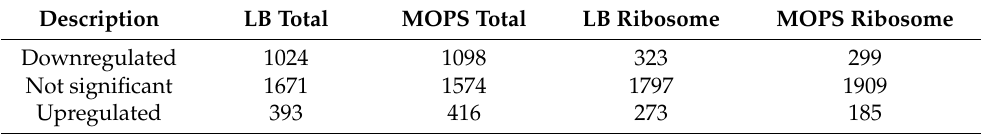
Figure 2. STARPA revealed over 12,000 sRNAs. ( a ) Venn diagram showing the number of identified processing products in total and ribosome-associated RNA libraries, with a cutoff threshold of 10 reads per million or higher. ( b ) Pie charts showing the percentage of identified RNAs by biotype for total and ribosome-associated RNA libraries. ( c ) Venn diagram showing the number of upregulated processing products in the stationary phase, in total, and ribosome-associated RNA libraries deriving from cells grown in LB and MOPS. Table 1. Differential expression analysis. Table showing the number of downregulated, unchanged (not significant), and upregulated sRNAs in total RNA libraries and ribosome-associated RNA All numbers were based on differential expression analysis in the stationary phase in comparison to the exponential